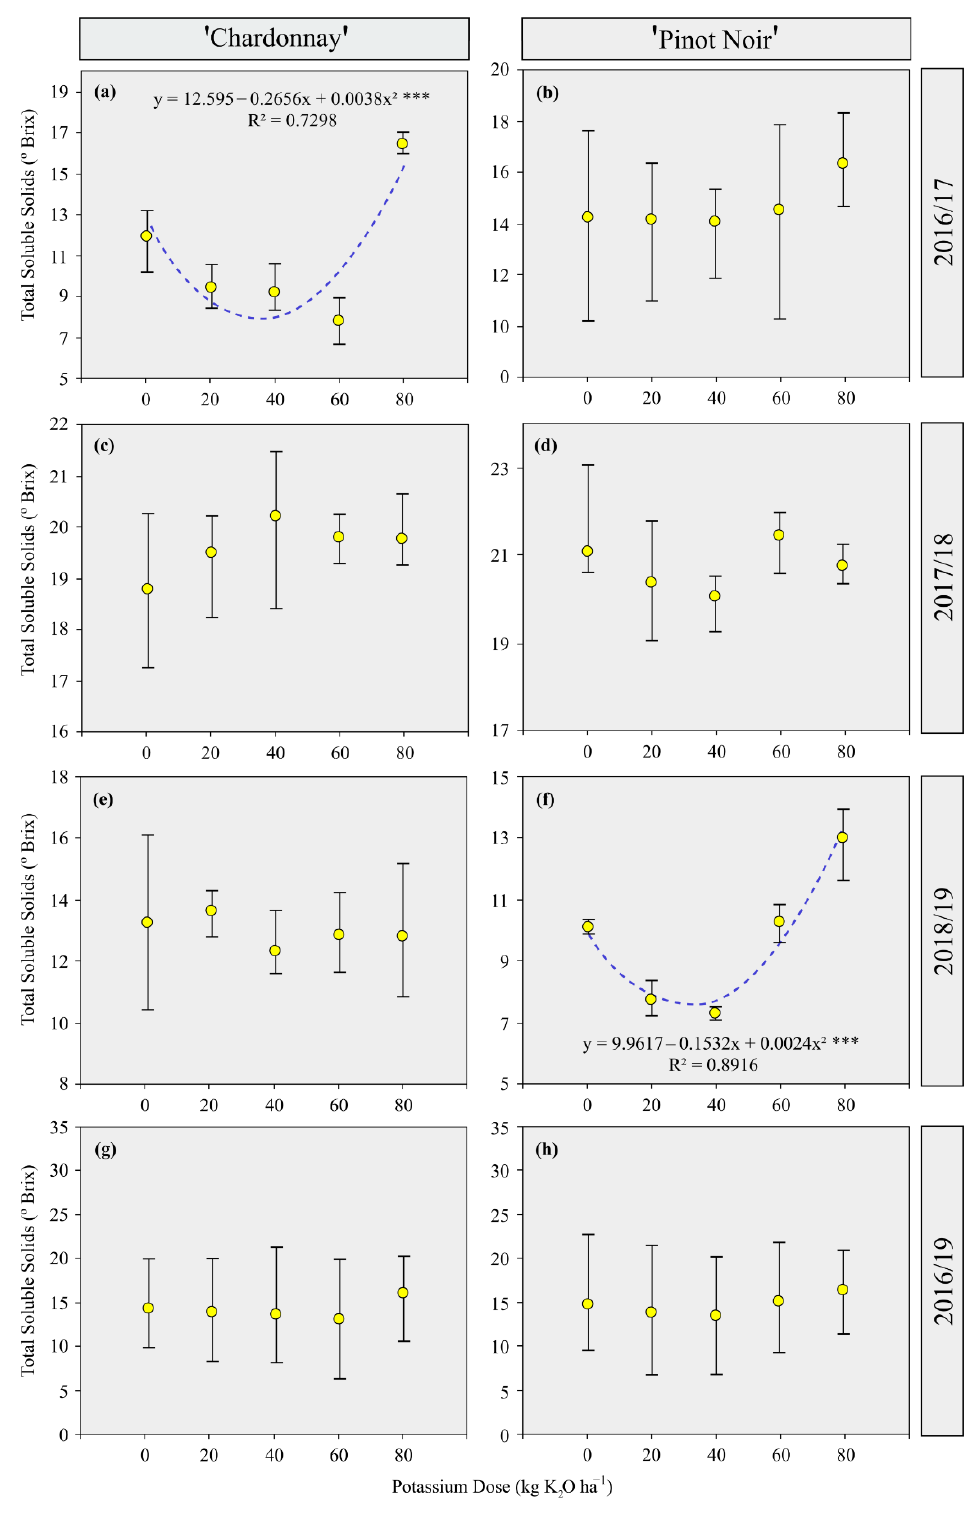
Figure 10. Potassium maximum technical efficiency (MTE) doses in relation to the total soluble solids (TSS) of ‘Chardonnay’ ( a , c , e , g ) and ‘Pinot Noir’ ( b , d , f , h ), in 2016/17, 2017/18, 2018/19 and in a compilation of the crop seasons submitted to the application soil fertilized with K. The blue dotted line is the behavior of the equation. “***” Significant at 0.1% ( p < 0.001).